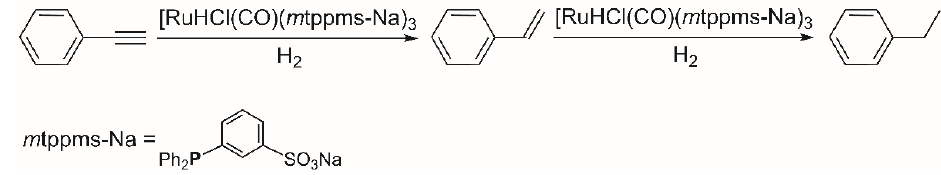
Figure 1. Hydrogenation of phenylacetylene.